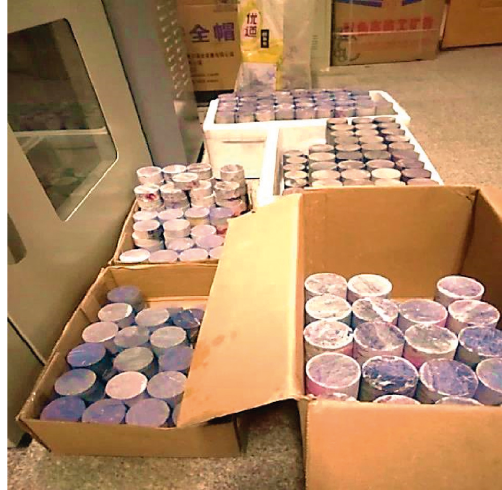
Figure 2: Some of the prepared core rock samples under